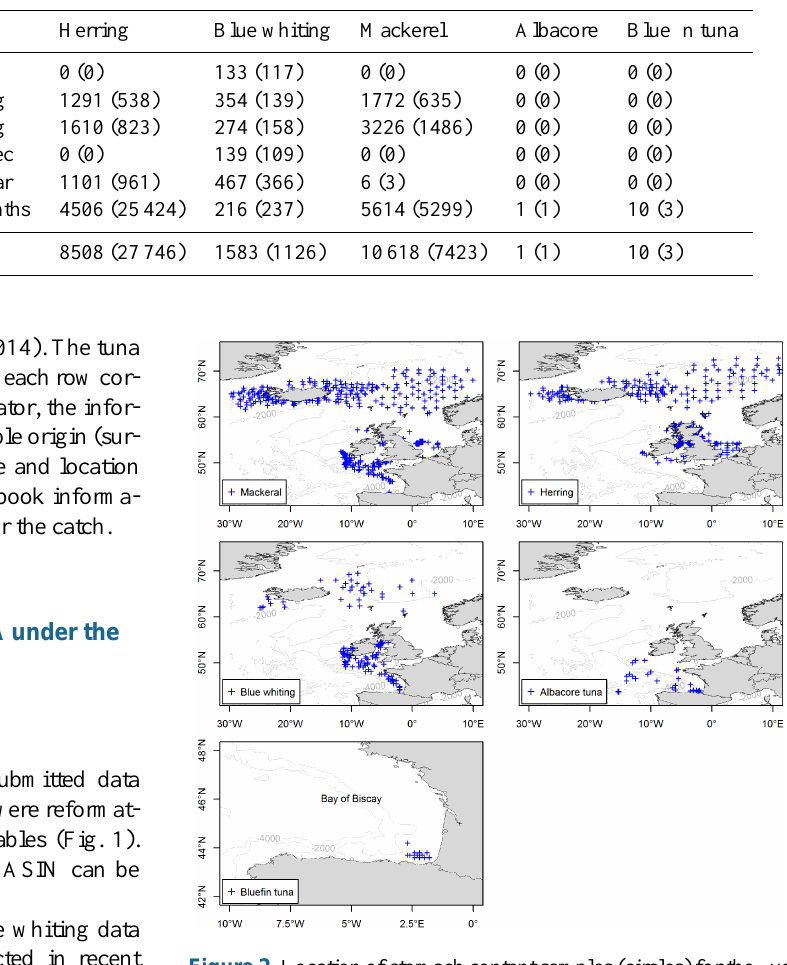
Table 1. Number of stomach content records for pelagic fish species submitted to the DAPSTOM database as part of EURO-BASIN. Number of individual stomachs included in parentheses.